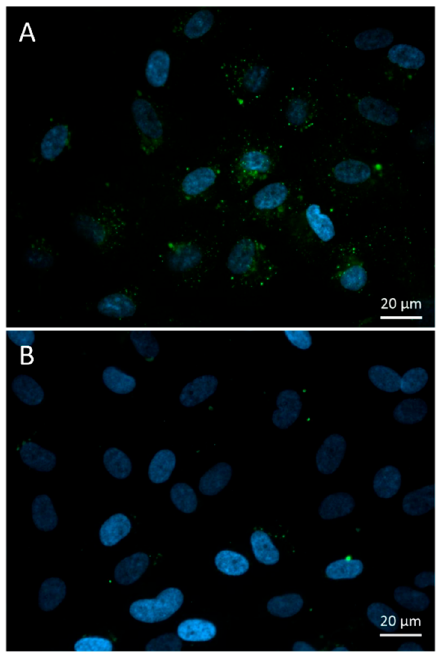
Figure 5. Fluorescence microscopic images of FITC-HPBCD treated ( A ) and untreated ( B ) human umbilical vein endothelial cells (HUVECs). Endocytotic green vesicles can be observed in the cytoplasm ( A ), while some autofluorescent vesicles can be seen in the control cells ( B ). (Green—FITC-HPBCD, blue—cell nuclei).